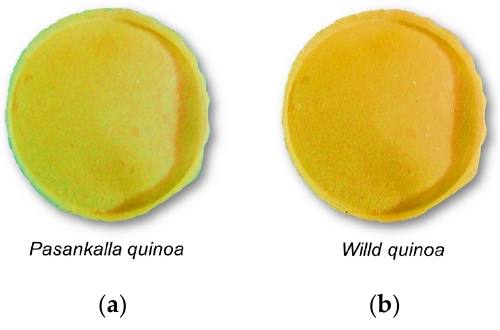
Figure 2. Edible films. ( a ) QP edible film and ( b ) QW edible films.